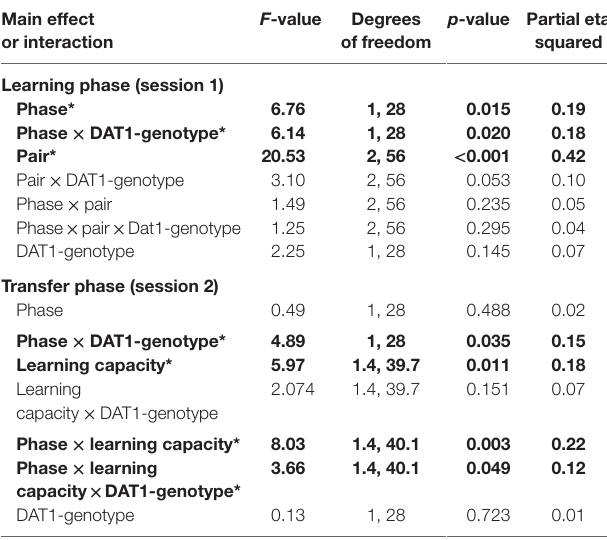
Table 1 | Main effects and interactions in the cycle group ( n =